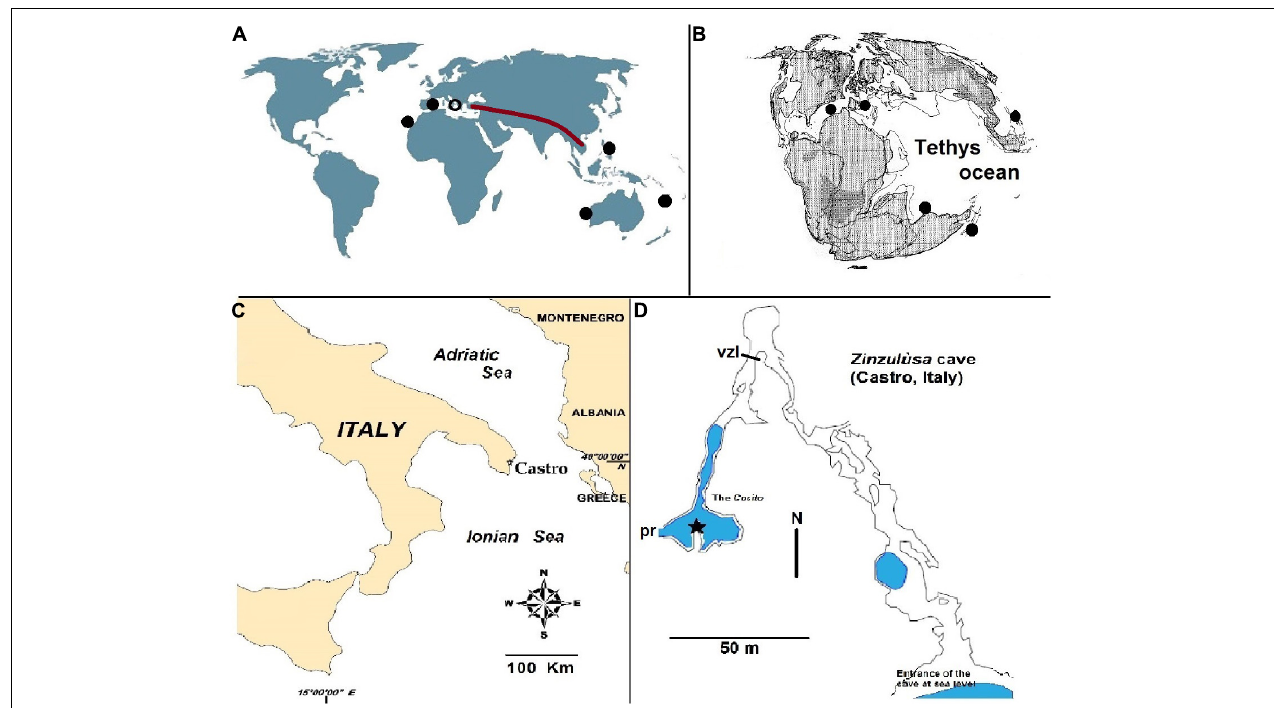
FIGURE 1 | Geographic localization of Zinzulùsa cave. (A) World map with sites hosting copepods of the genus Stygocyclopia (black discks). The position of Zinzulùsa cave is indicated with a black circle. The brown line indicates the ancient Tethyan coastline, uplifted by the Alpine–Himalayan orogenesis. (B) The Tethys ocean geography of 155 Million years ago (Oxfordian) (modified from Smith et al., 1994). (C) Geographic position of Castro (municipality where is the Zinzùlusa cave). (D) Map of the Zinzulùsa cave with an indication of the water level (in blue); black star, position of the collecting device; vzl, visitors zone limit; pr, prosecution of the submerged part (not